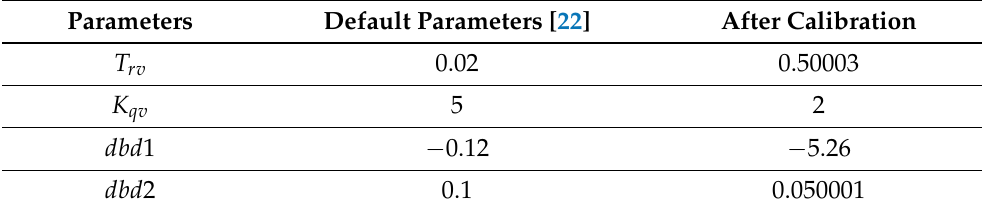
Table 2. Results before and after parameter